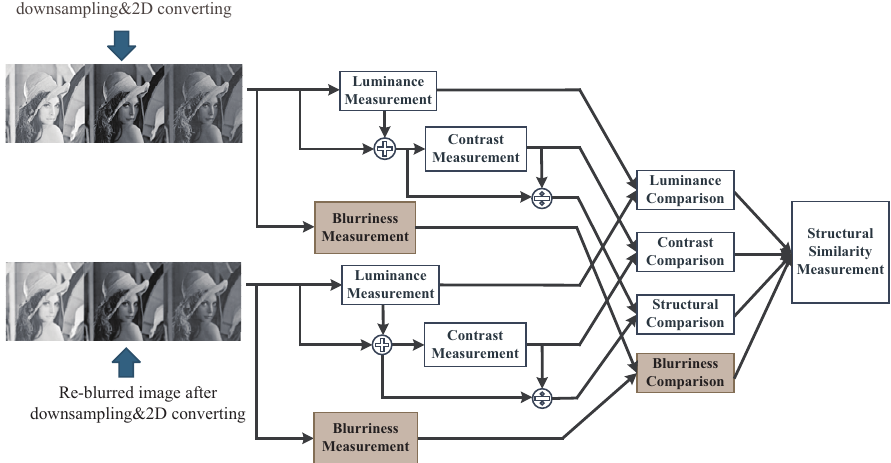
Figure 3. Feature extraction and structural similarity measurement. We extract four features, i.e., luminance, contrast, structural and blurriness, of the down-sampled 2D mode images and score structural similarity index by computing four features